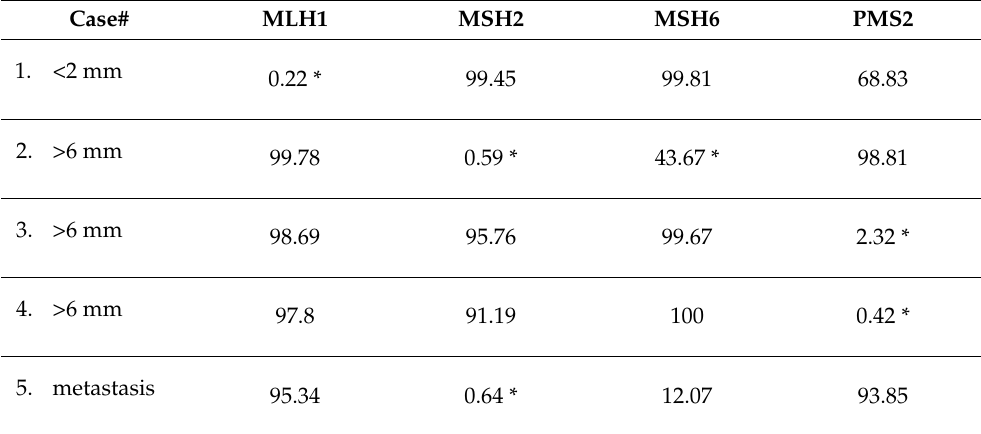
Table 2. Description of five cutaneous squamous cell carcinoma cases with low-level * mismatch repair protein expression